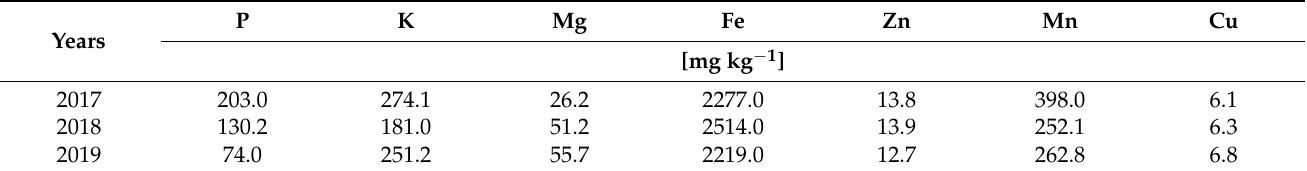
Table 1. Content of available nutrients (depth of 0–60 cm).